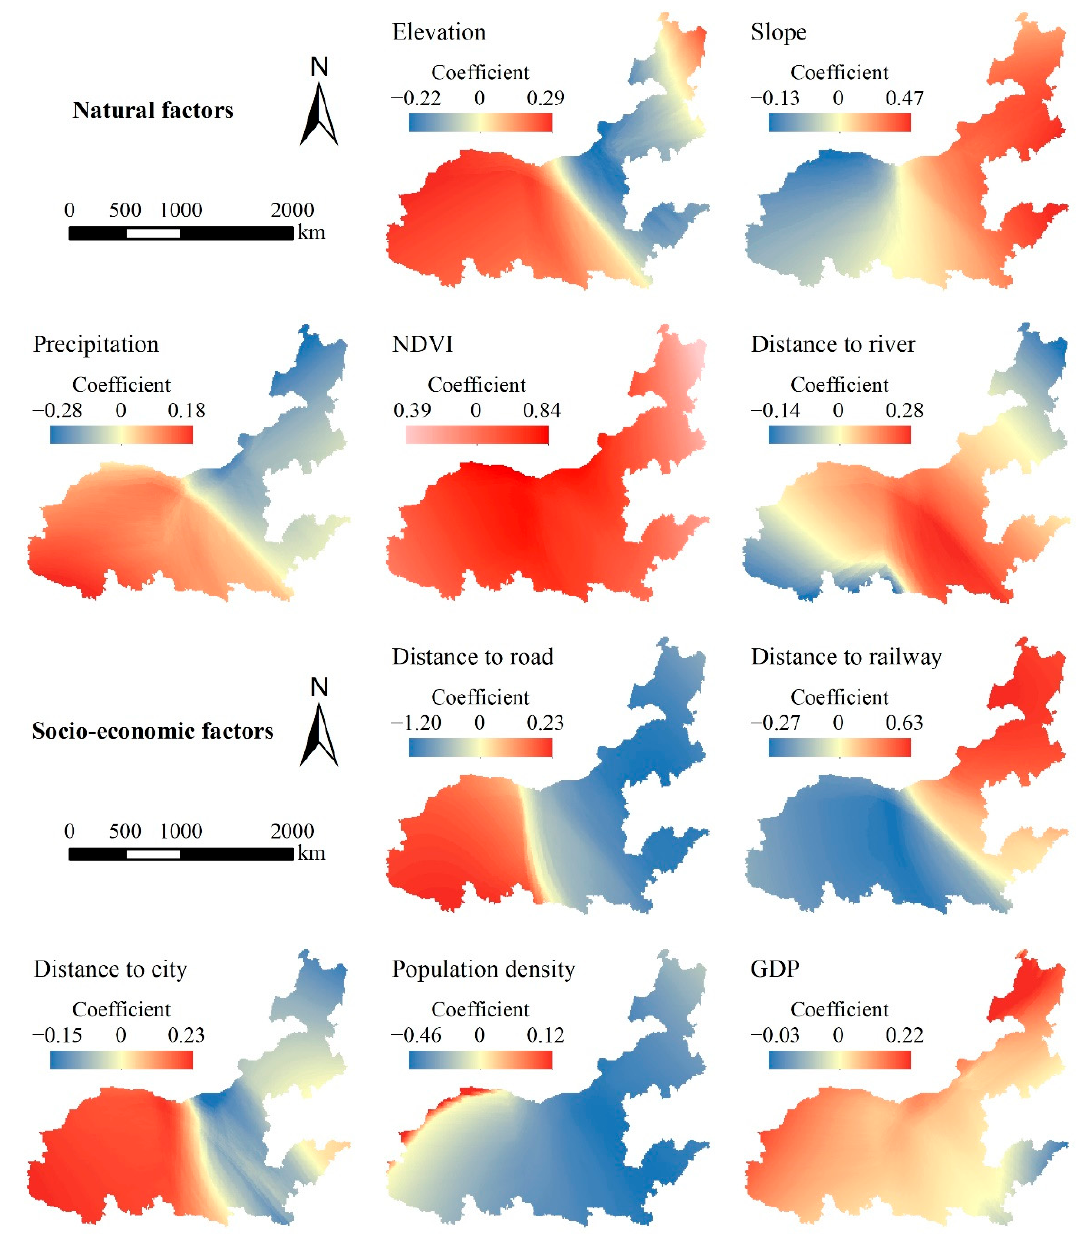
Figure 6. Spatial distribution of regression coefficients of influencing factors.